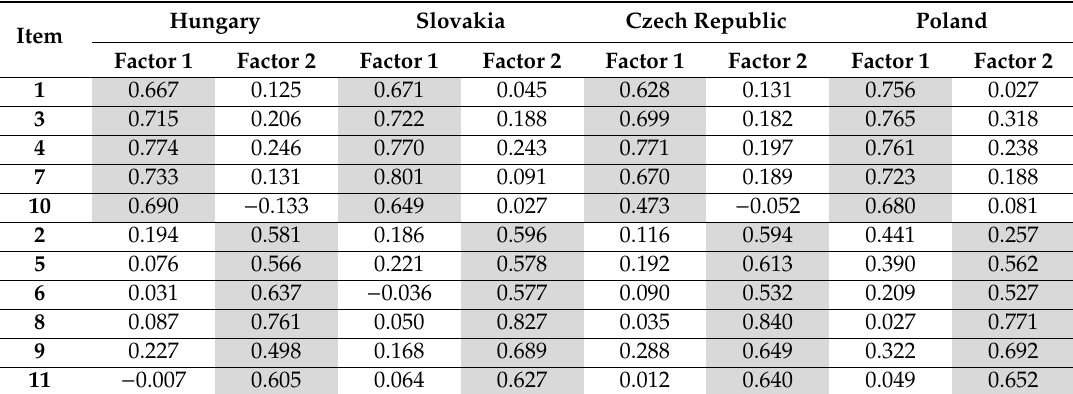
Table 5. Exploratory factor analysis of the BMQ-Specific